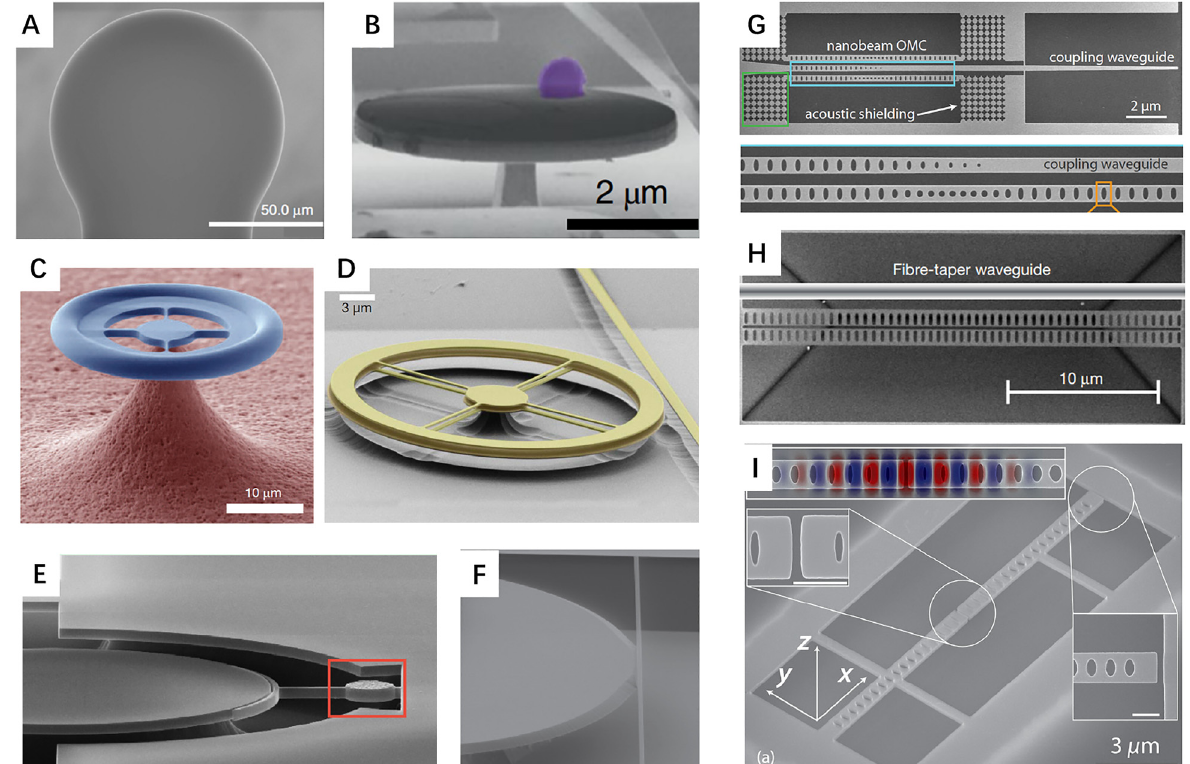
Figure 3: Various optomechanical sensing platforms. (A)–(D) Are whispering gallery mode microresonators: (A) silica microsphere [67]. (B) GaAs microdisk [68]. (C) Silica microtoroid [69]. (D) Silicon nitride double disks [70]. (E) Microcantilever mechanical resonator coupled with a microdisk cavity [71]. (F) Nanostring mechanical resonator coupled with a microdisk cavity [35]. (G)–(I) are photonic crystal nanomechanical resonators, including single photonic crystal nanobeam cavities (G) [72], two coupled photonic crystal nanobeam cavities (H) [73], split coupled photonic crystal nanobeam cavities (I)